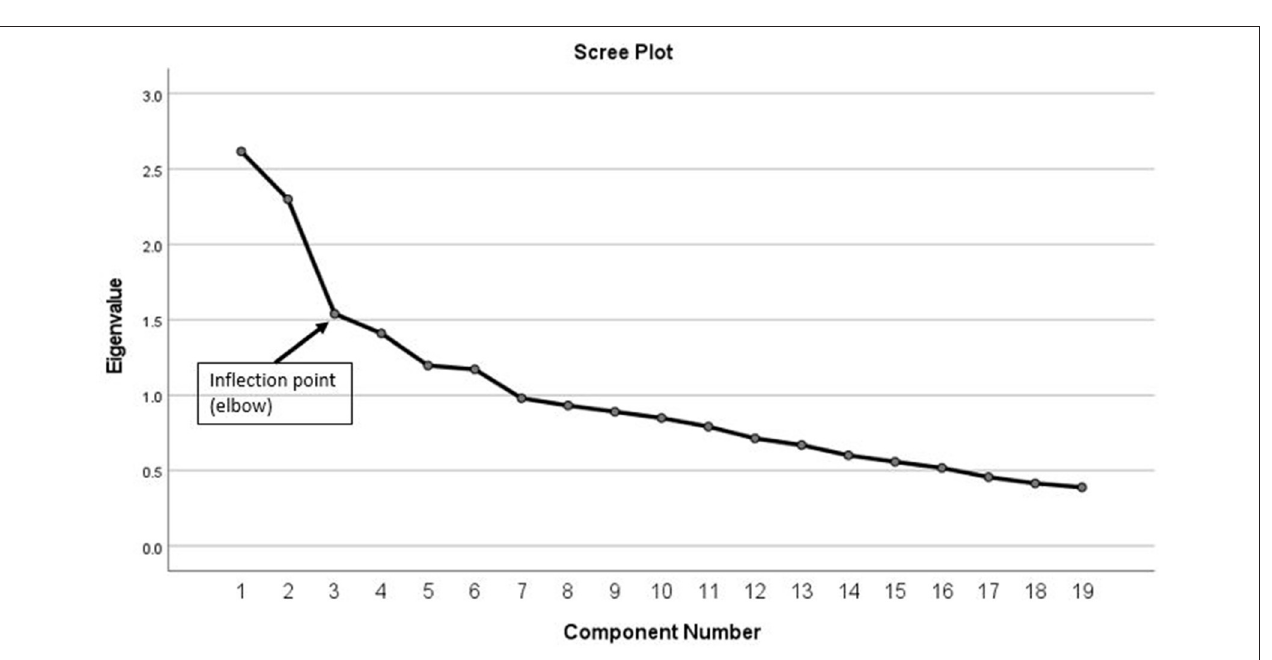
gene variants and the Traditional Emirati dietary